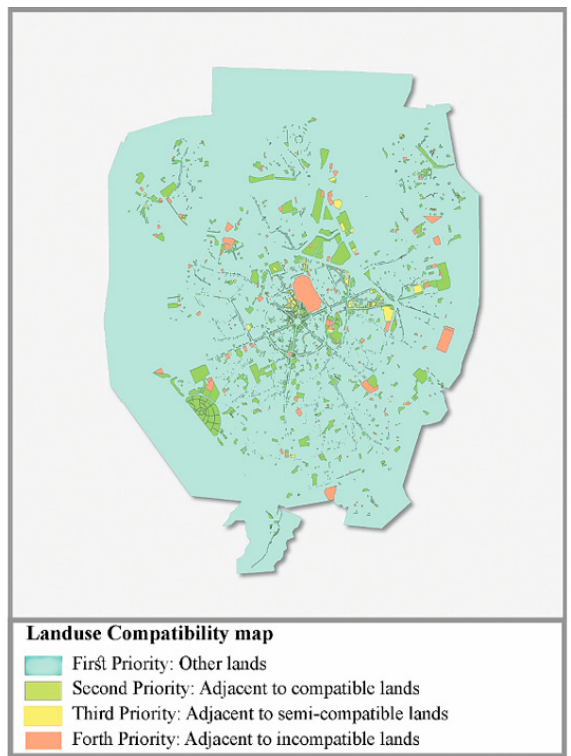
Figure 17. The land-use compatibility map of Hamedan based on the sub-criteria measures in Table 1.